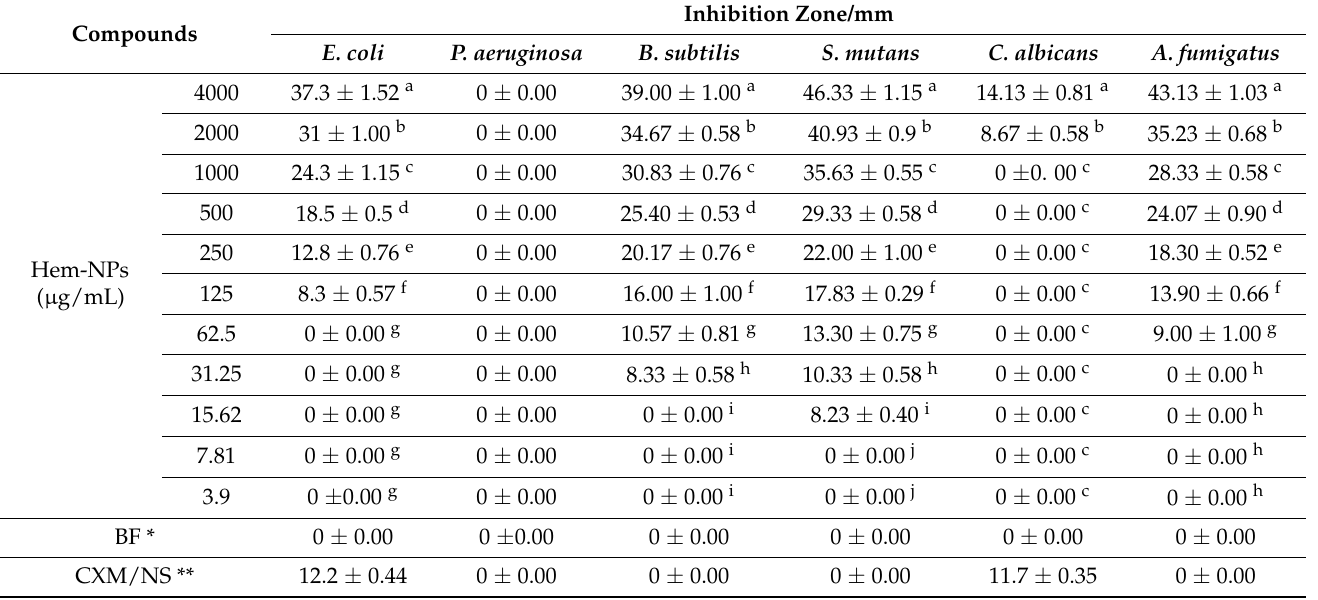
Table 1. Effect of different concentrations of Hem-NPs on bacterial and fungal strains.